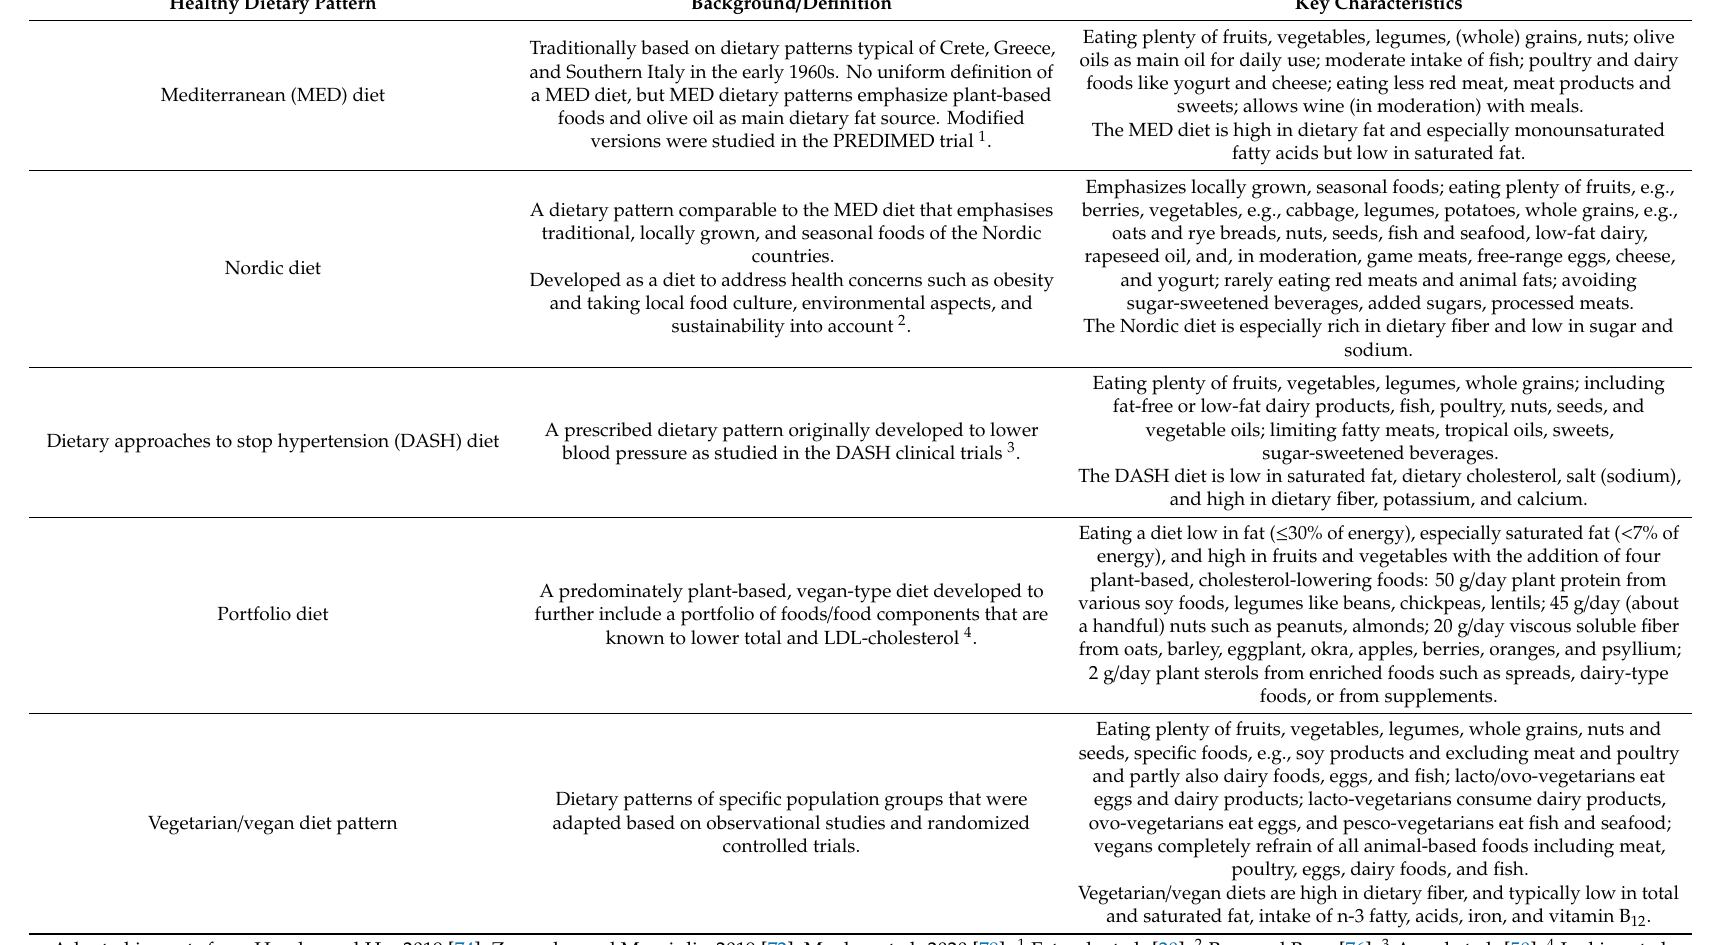
Table 2. Healthy dietary patterns for the management of dyslipidemia and the prevention of cardiovascular diseases (CVD). Healthy Dietary